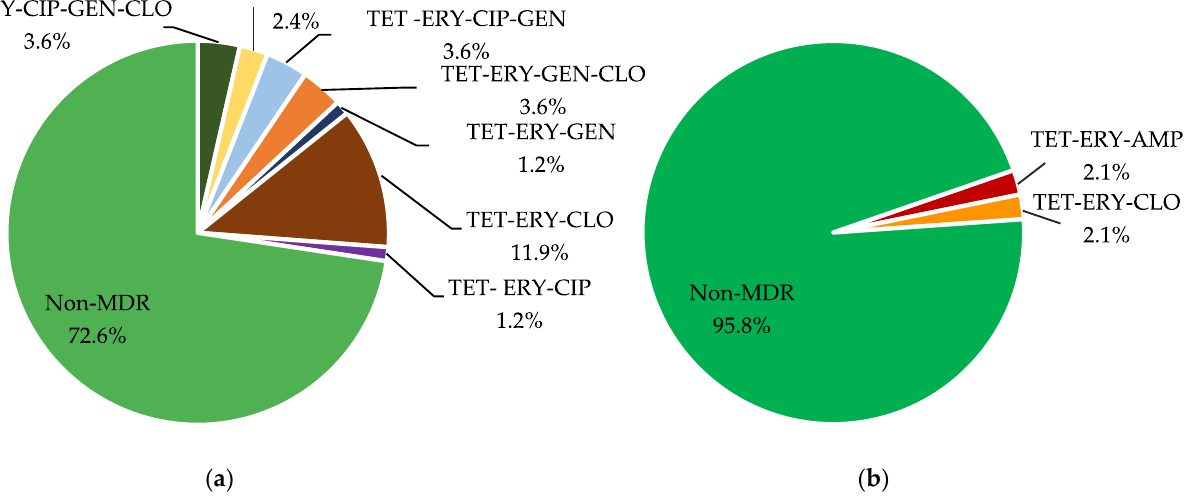
Figure 2. Diversity of multidrug resistance profiles found in ( a ) E. faecalis ( n = 84) and ( b ) E. faecium ( n = 48) strains from swine using the agar dilution susceptibility test. MDR, Multidrug-resistant; TET, Tetracycline; ERY, Erythromycin; LZD, Linezolid; AMP, Ampicillin; CLO, Chloramphenicol; CIP, Ciprofloxacin; GEN, Gentamicin.